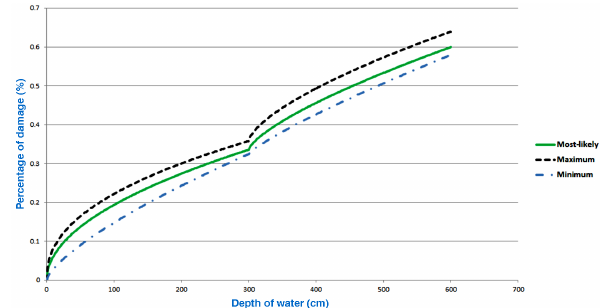
Figure 10. Visualisation of minimum, most-likely and maximum damage functions, calculated by bootstrap and chi-square test, for one-storey buildings with timber wall. Figure 11. Visualisation of minimum, most-likely and maximum damage functions, calculated by bootstrap and chi-square test, for two-storey buildings with brick